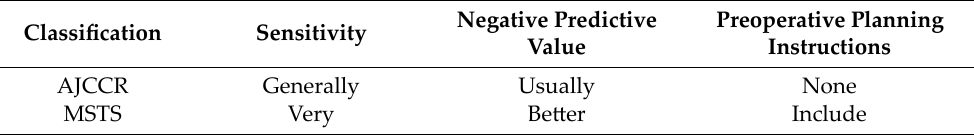
Table 1. Comparison of two classifications of surgical margins for OS